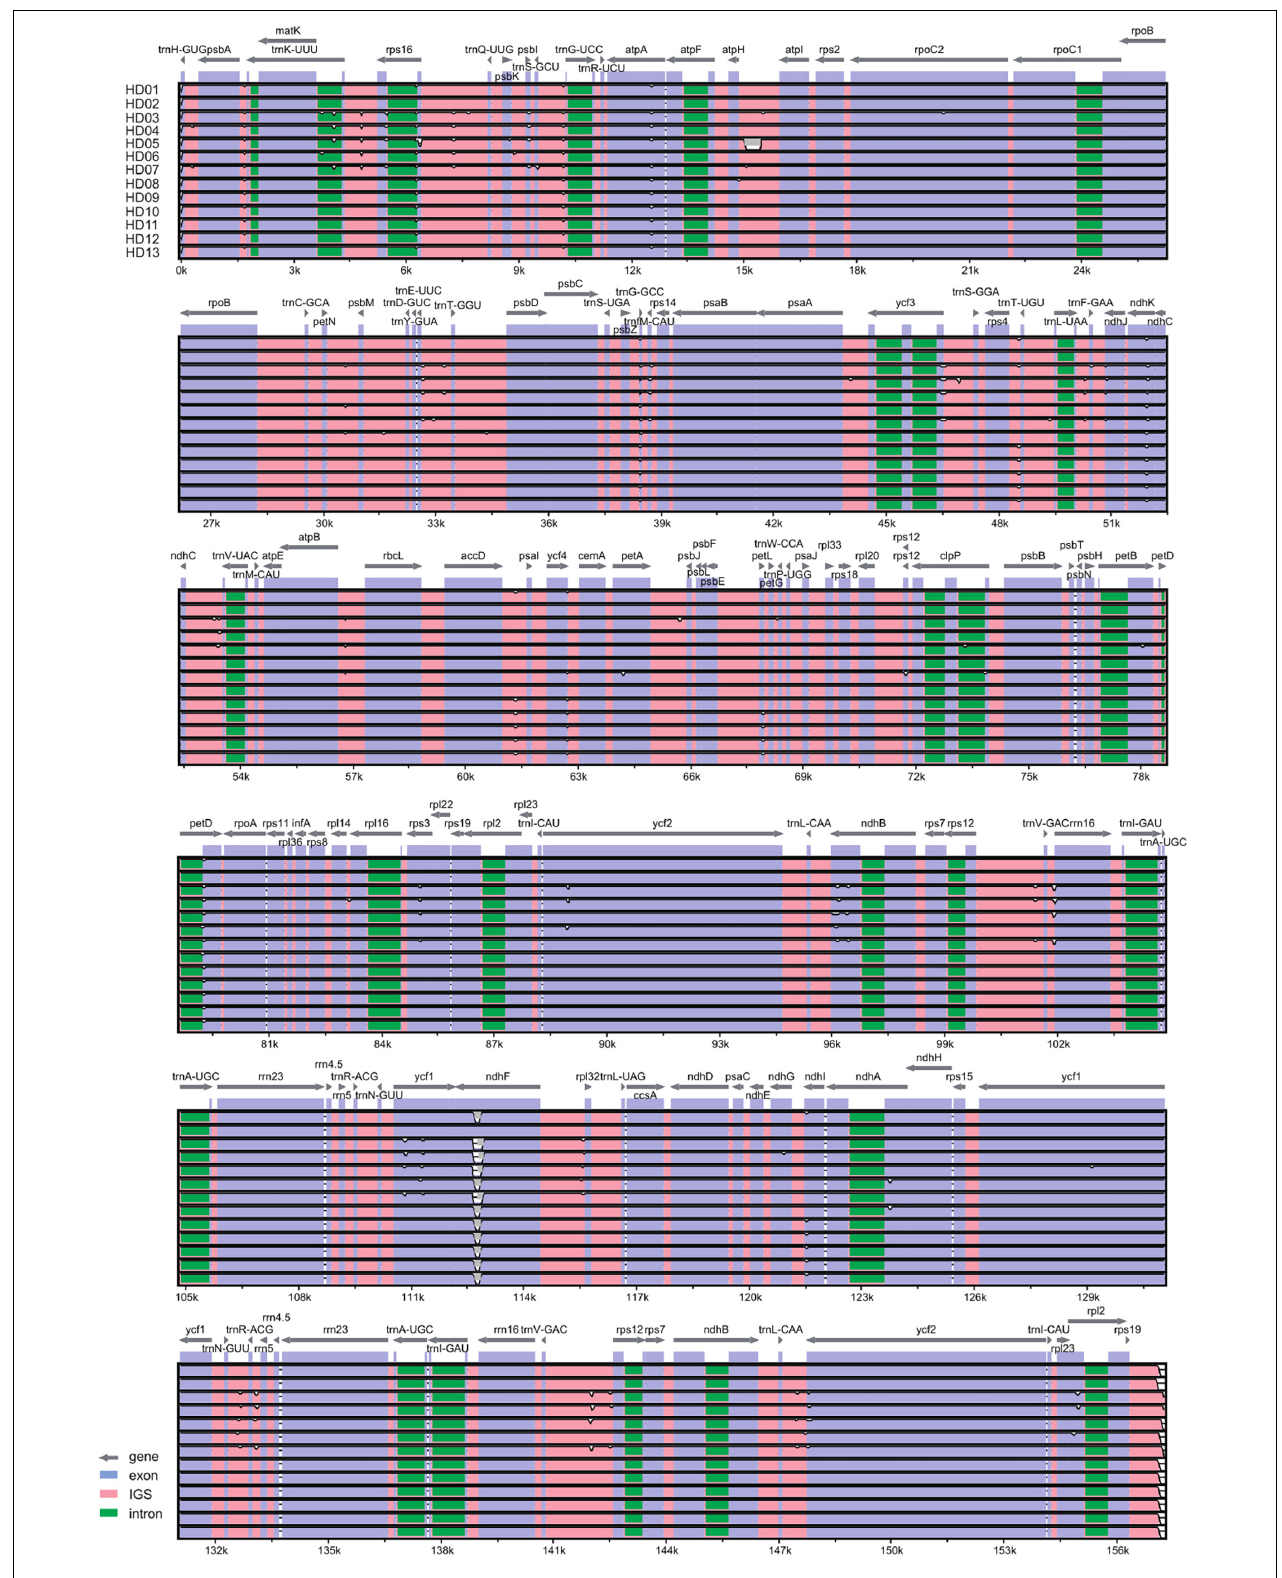
FIGURE 3 | Analysis of hotspots of evolutionary branches of the genomic system.